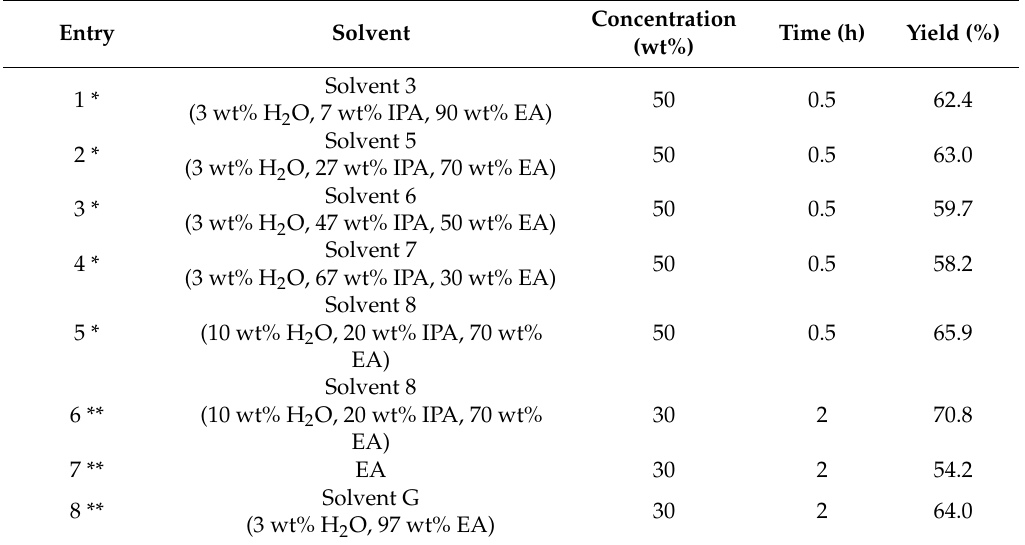
Table 1. Hydrogenation of BE186 and BE503 using di ff erent ratios of IPA (wt%) in solvent mixtures. Entry Solvent